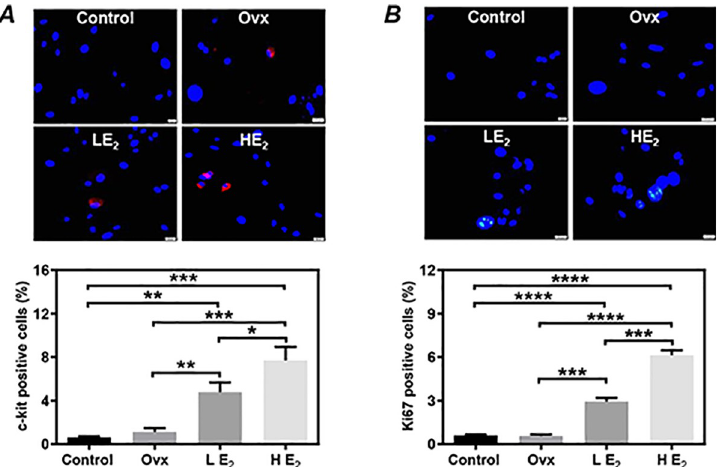
Fig 2. The expression of c-kit and Ki-67 in cardiac stem cells (CSCs). Immunostaining was performed to evaluate the expression of c-kit (A) and Ki-67 (B) in twice-passaged CSCs. Representative images (upper) and quantitative data (lower) are shown. The nuclei were labeled with DAPI. Scale bar: 20 μ m. Control: sham-operated mice, Ovx: ovariectomized mice, LE 2 : ovariectomized mice received a low dose of 17 β -estradiol (0.01 mg/60 days), HE 2 : ovariectomized mice received a high dose of 17 β -estradiol (0.18 mg/60 days). All data are mean ± SD from 3 independent experiments (n = 3 for each group). � P < 0.05, �� P < 0.01, ��� P < 0.001, ���� P < 0.0001.